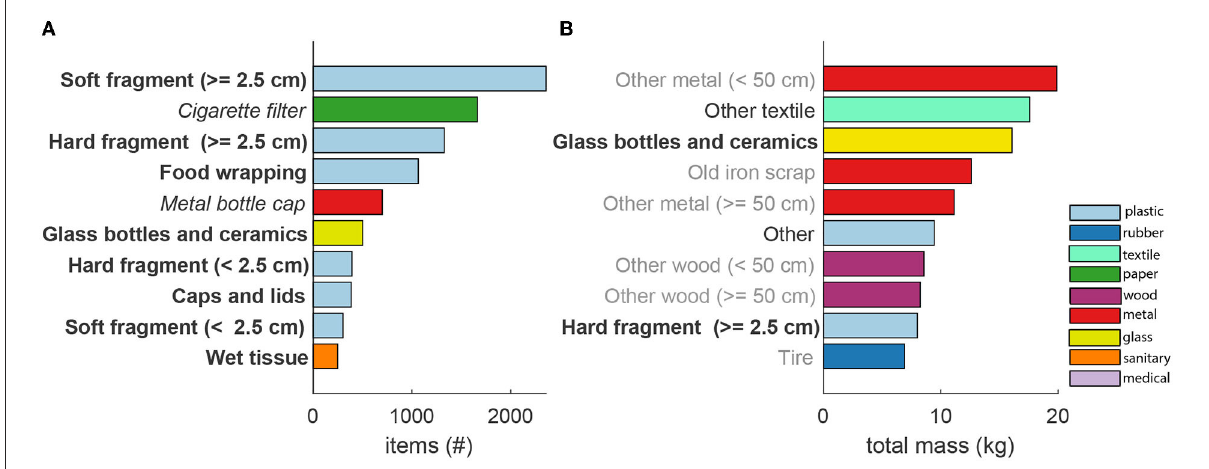
FIGURE3 List of the top 10 most frequently found items based upon (A) item amount and (B) mass. Item categories are defined as homogeneous (italic), heterogeneous (bold), mixed (normal), or undefined (gray) based on the analysis below.